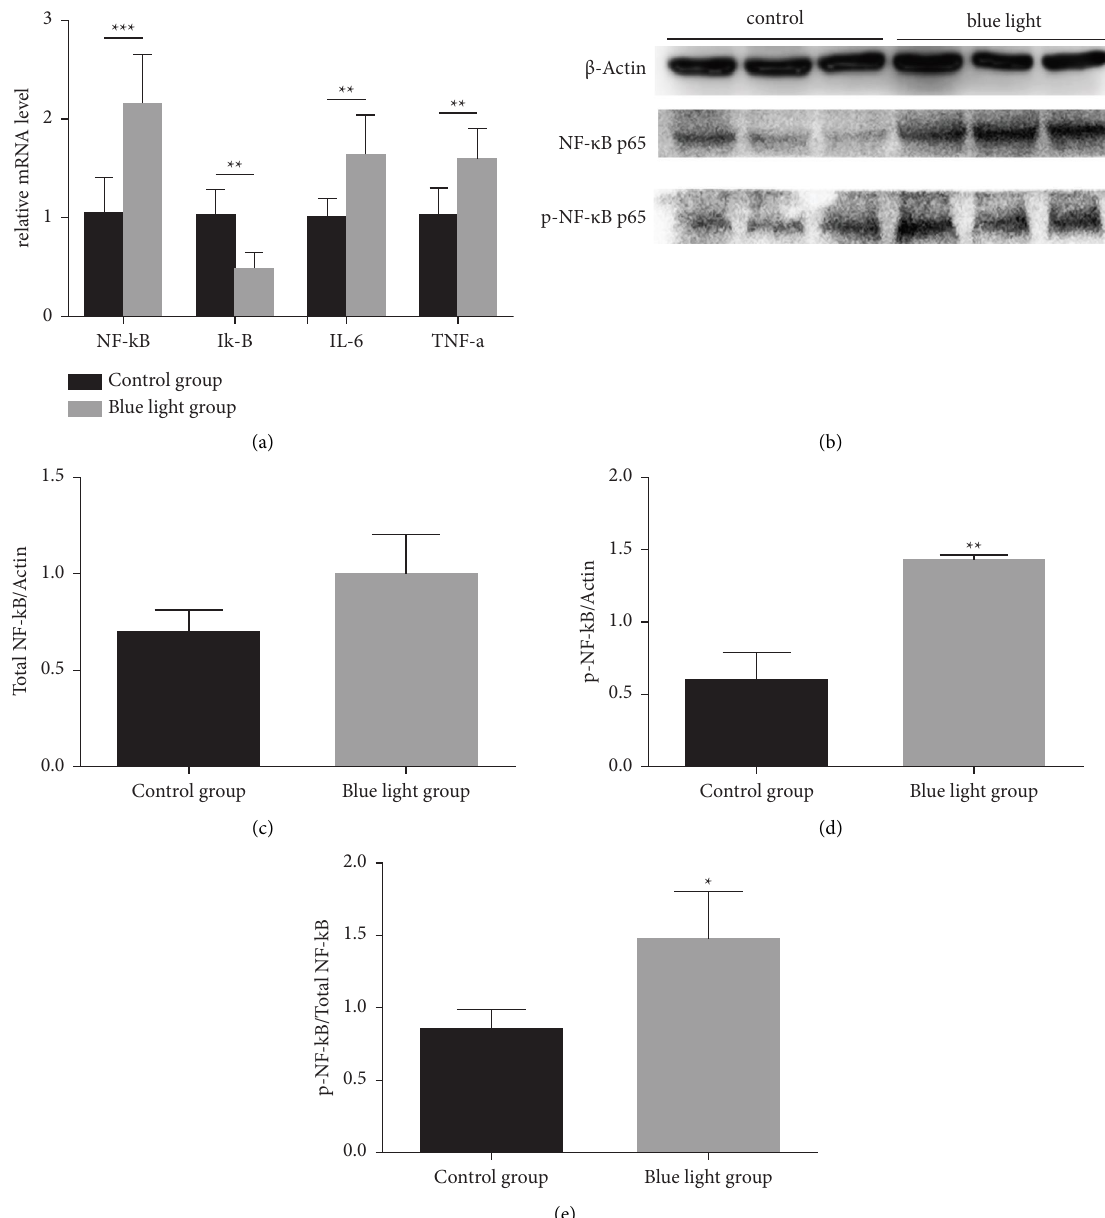
Figure 4: NF- κ B pathway-related proteins in the cornea after blue light irradiation. (a) Te production of NF- κ B, I κ -B, IL-6, and TNF- α were evaluated by real-time PCR, with GAPDH as a loading control. After treatment for 28days, the mRNA levels of NF- κ B, TNF- α , and